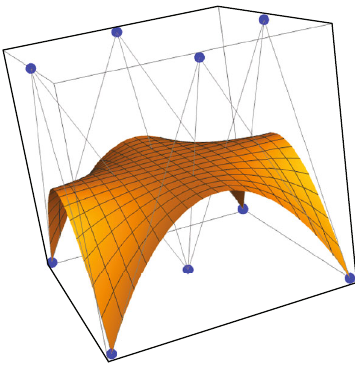
Figure 1: A biquadratic Bézier surface with shifted knots for η = 0 : 2 and λ = 0 : 2 .